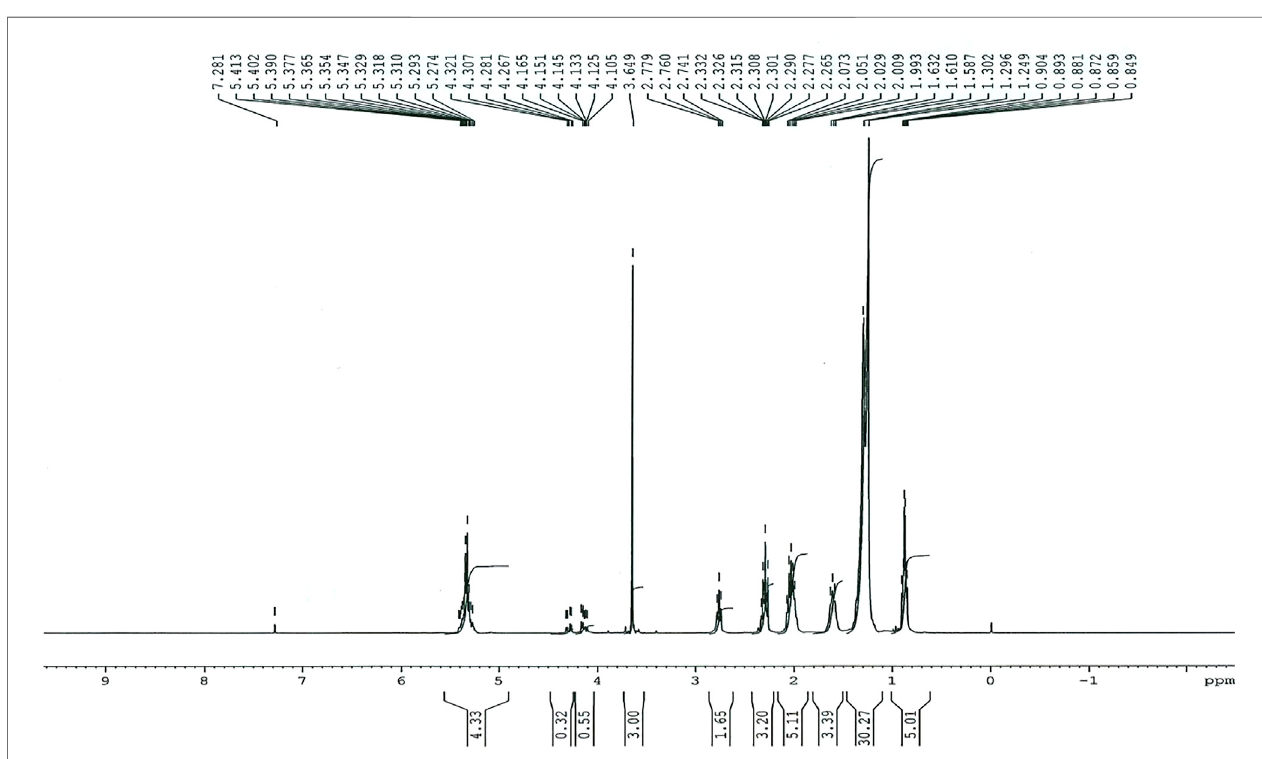
FIGURE 9 | 1 H NMR spectrum showing the chemical bonding in the Dodonaea plant prepared biodiesel.